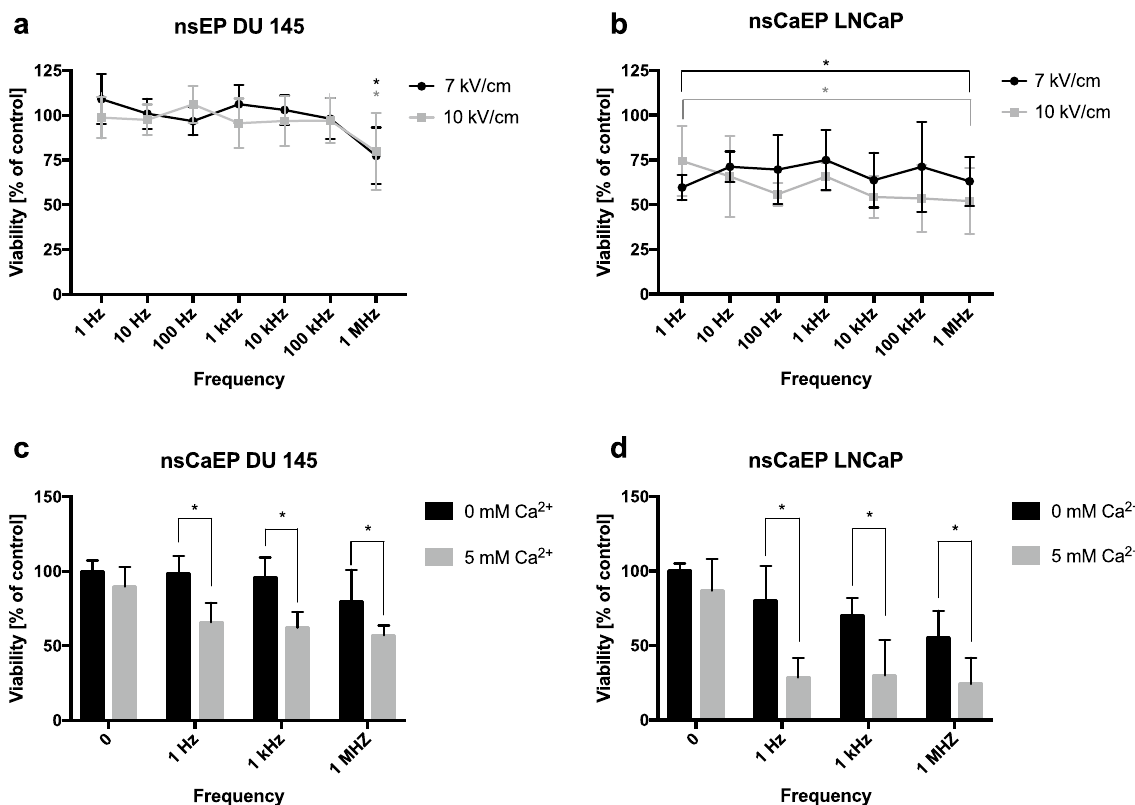
Figure 2. Viability of DU 145 and LNCaP cells after expousure to 25, 200 ns PEFs ( a – d ). Cells were permeabilized in suspension in a 1-mm gap electroporation cuvette. Viability of the cells as a function of electric field frequency. ( a , b ) The effect of PEFs was measured at two different electric field intensities. ( c , d ) Viability of cells after exposure to PEFs in medium with different Ca 2+ concentration. Viability was assessed with MTT assay. Graphs are representative of at least 3 independent experiments. Data are mean ± SD (n = 3–5 independent experiments). (*) indicates statistically significant differences between the sample and control ( a , b ), or pair of samples ( c , d ) (ANOVA, p <